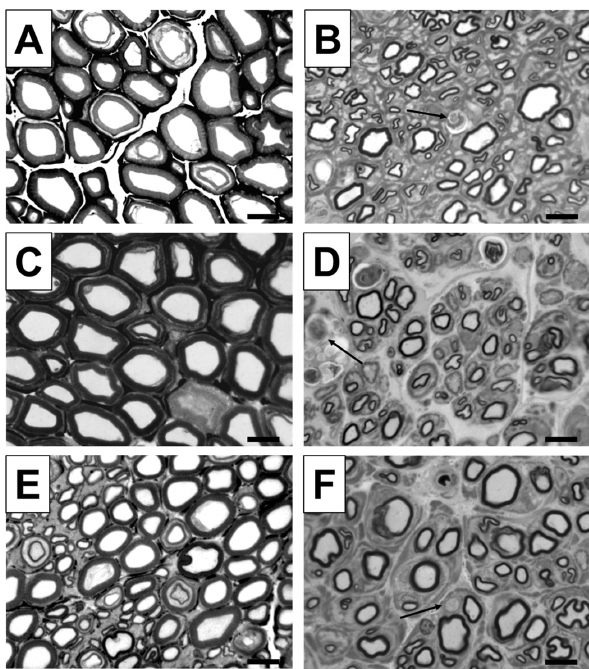
Fig. 3 Representative pictures of toluidine blue-stained semi-thin cross-sections of distal nerve segments 6 months after reconstruction surgery. Images show healthy nerve segments ( A, C, E ) serving as control compared with distal nerve segments of sciatic nerves, which were reconstructed with autologous nerve grafts (ANGs) ( B, D, F ). Healthy nerve samples reveal axons with large diameters and thick myelin sheaths. Pictures of distal nerve segments of autologous nerve graft reconstructed sciatic nerves show successfully regenerated smaller axons with thinner myelin sheaths as well as axonal degen- eration (indicated by arrow). Black scale bars display 10µm.